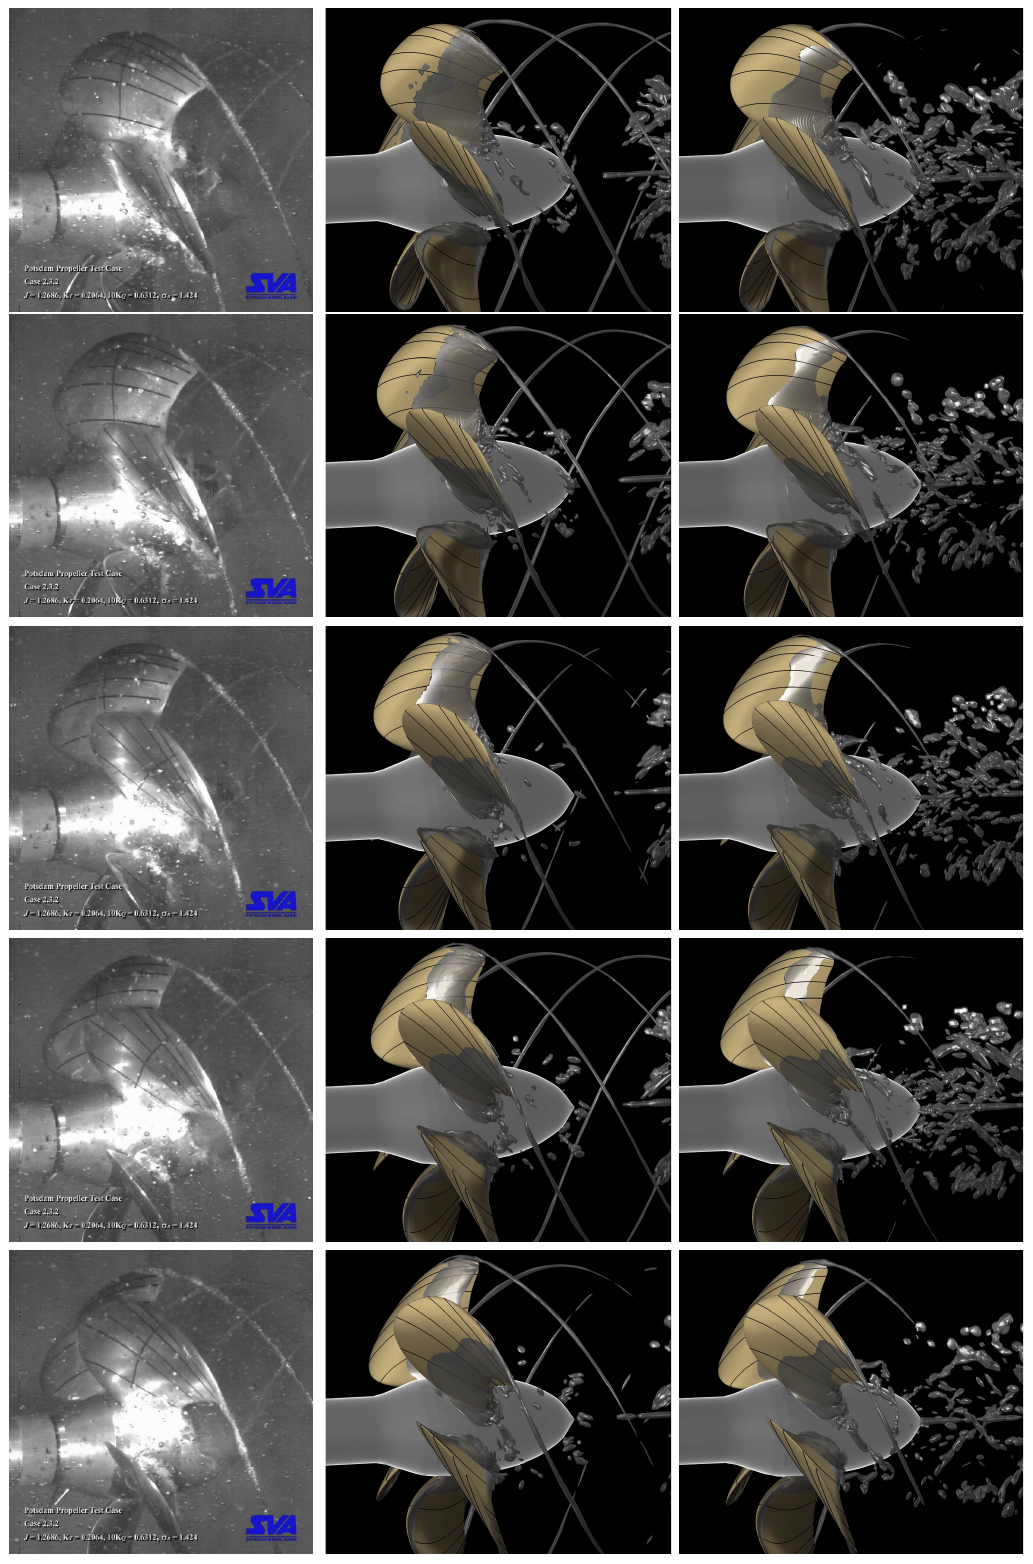
Figure 28. Cavitation growth and detachment in model- and full-scale PPTC Case 2 conditions. Left column: Experiments (model scale), reproduced with permission from Lars Lübke (SVA). Middle column: DDES Model scale. Right column: DDES Full scale. The time increment between each frame corresponds to 10 degrees of propeller